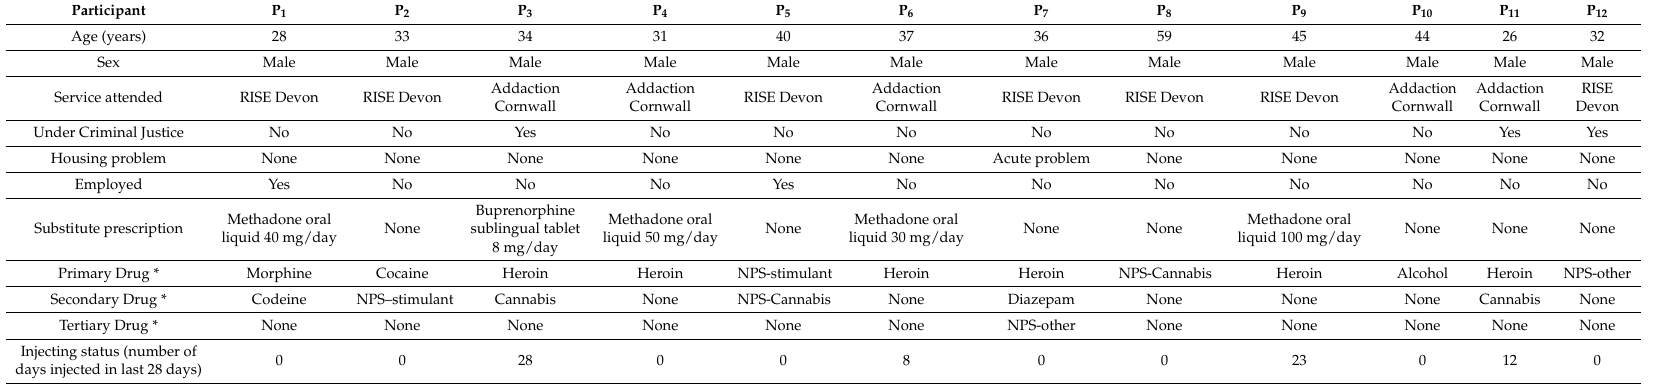
Table 1. Summary of information obtained from the electronic record system (Halo for all 12